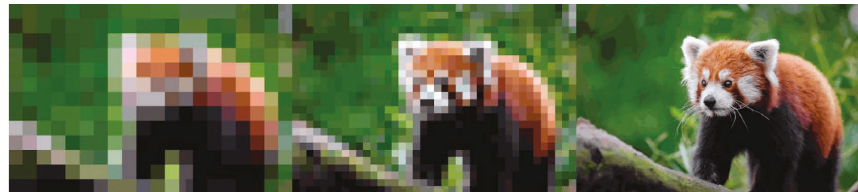
Figure 1: Example of a red panda picture used in the recognition game.